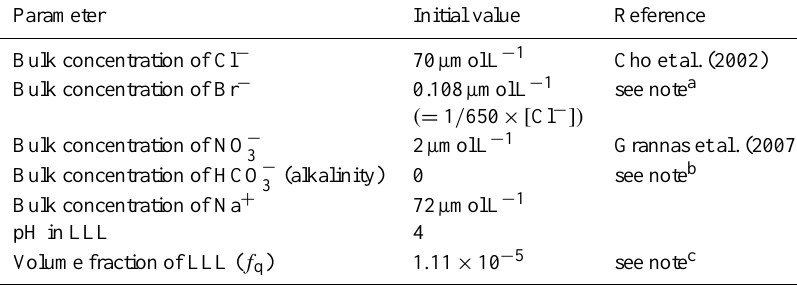
Table 3. Initial conditions for condensed-phase chemistry in the snowpack. Parameter Initial value